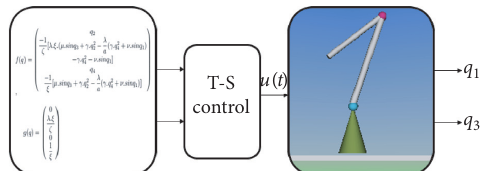
Figure 4: State feedback fuzzy block diagram for the DIP system.